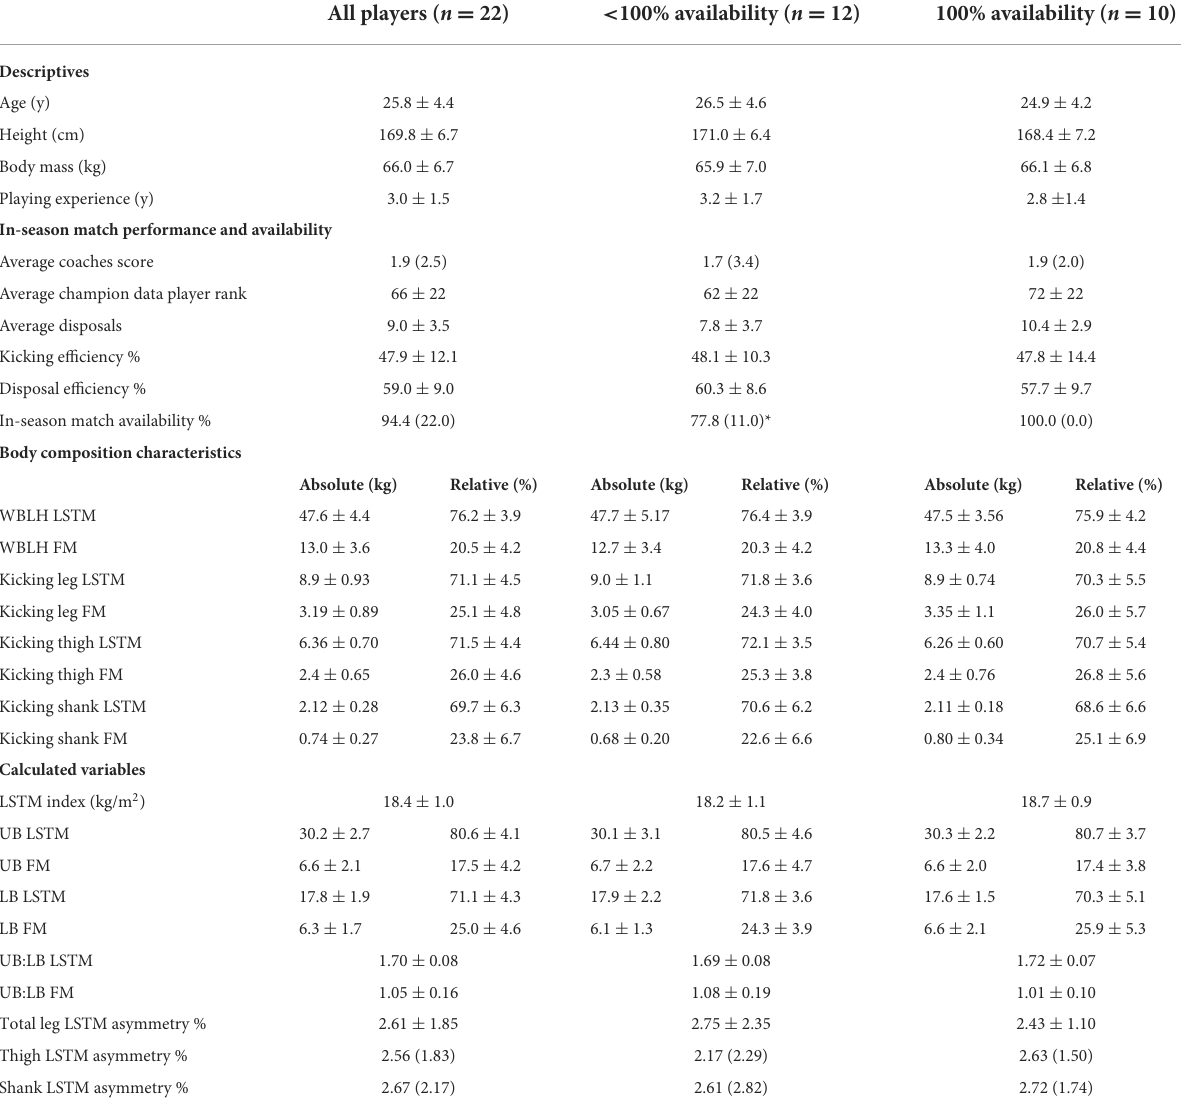
TABLE 1 Body composition and match performance (mean ± SD) data of all AFLW players and those within each in-season availability group. All players ( n =